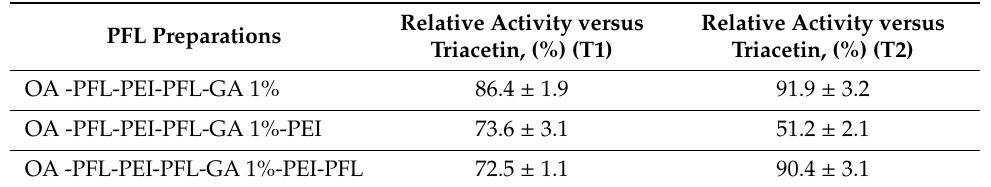
Table 3. E ff ect of the glutaraldehyde treatment of the PFL biocatalysts on enzyme activity in the